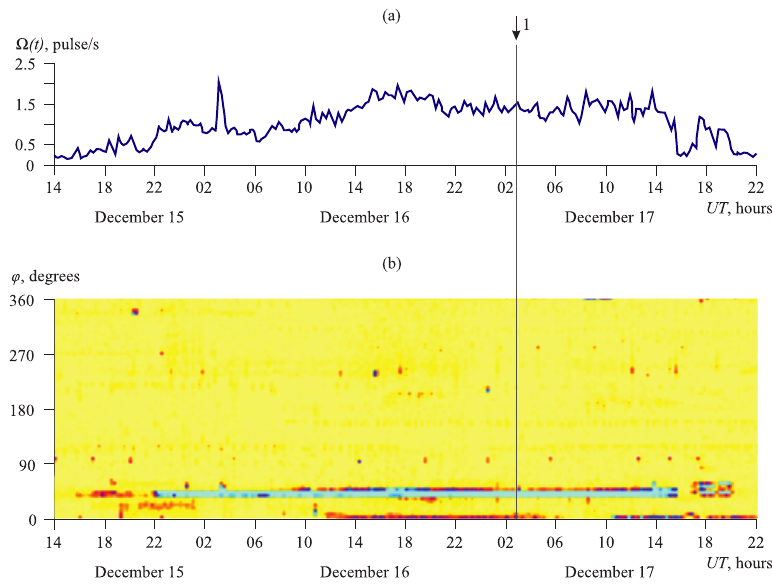
Figure 15. Period before and after the earthquake with M l = 4.4 occurred on 17 December 2012: ( a ) acoustic activity Ω ( t ) and ( b ) its azimuthal distribution D ( ϕ , t ) . The color shows the number of detected pulses ascending from white to